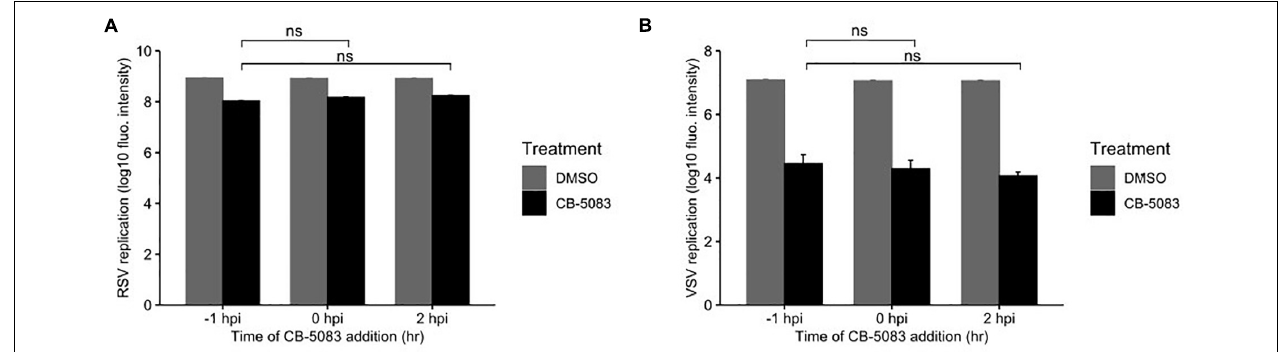
FIGURE 3 | VCP/p97 is not involved in the early steps of infection. The VCP/p97 inhibitor CB-5083 was added at the indicated time point relative to infection (hours post-infection, hpi) with RSV (A) or VSV (B) and virus production was quantified. Data represent the mean and SEM of three replicates. ns, p > 0.05 by t -test on log-transformed data vs. drug treatment 1 h prior to infection (–1